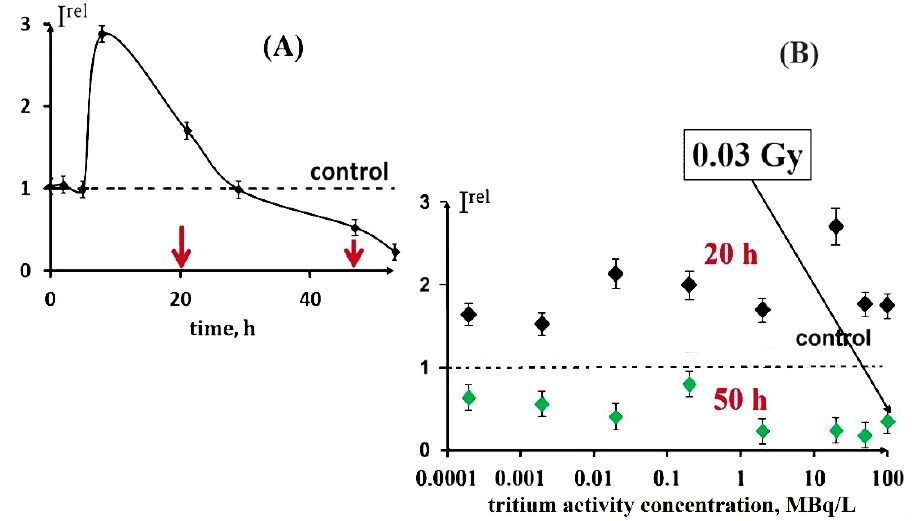
Figure 1. Effect of tritiated water on bioluminescence of bacteria. ( A ) Bioluminescence kinetics of bacteria in tritiated water, 2 MBq/L; red arrows denote times of sampling (20 and 50 h); ( B ) bioluminescence intensity vs. activity concentration of tritiated water at 20 h (black) and 50 h (green) exposures [16]. Adapted from Kudryasheva, N.S.; Kovel, E.S. Monitoring of low-intensity exposures via luminescent bioassays of different complexity: Cells, enzyme reactions, and fluorescent proteins. Int. J. Mol. Sci. 2019 , 20 , 4451.